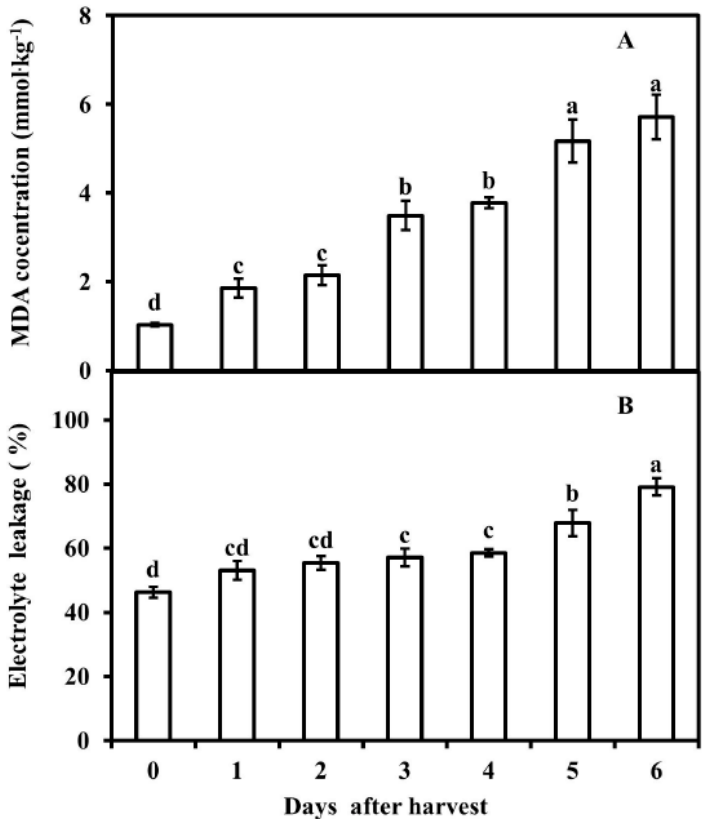
Figure 2. MDA concentration ( A ) and electrolyte leakage ( B ) of pericarp of fruit stored at room temperature (25 ± 2 °C) for 0 to 6 d. Vertical lines represent the standard deviation of the means of three replicates. Different small letters indicate significant difference at p < 0.05.